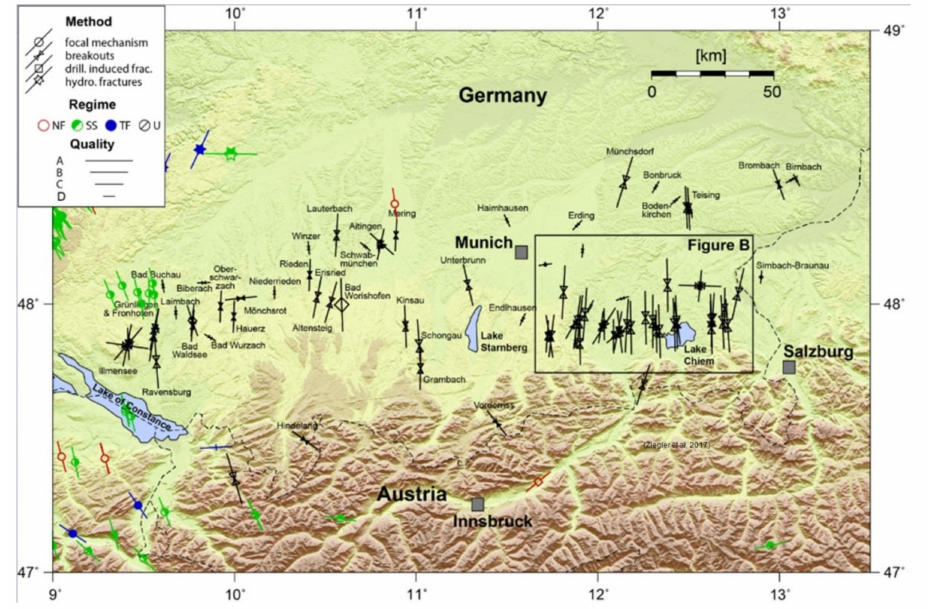
Figure 9. Orientation of the maximum horizontal stress in the Molasse Basin in southern Germany. The box represents the area of interest (modified after [4]). Reprint with permission [Reinecker et al.], 2010,